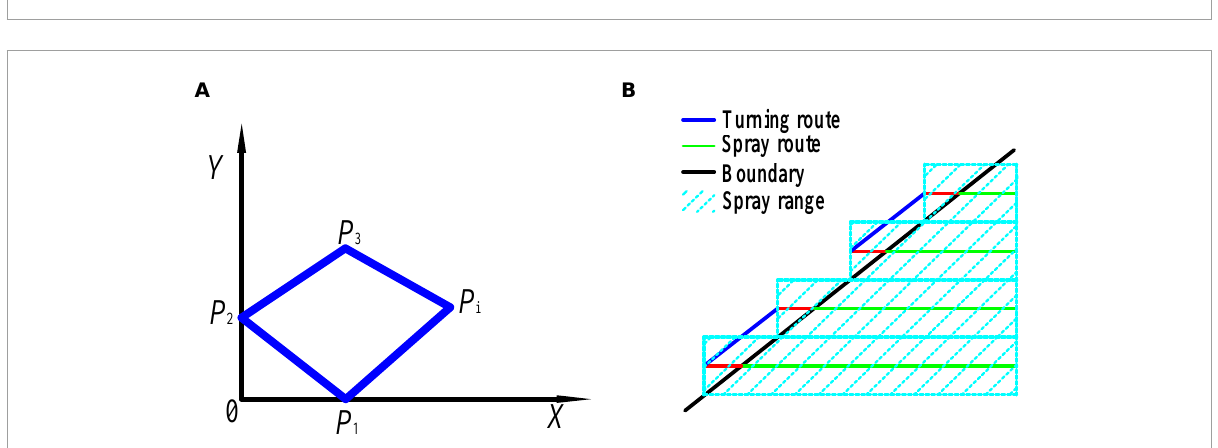
FIGURE2 Multi-tea field model.